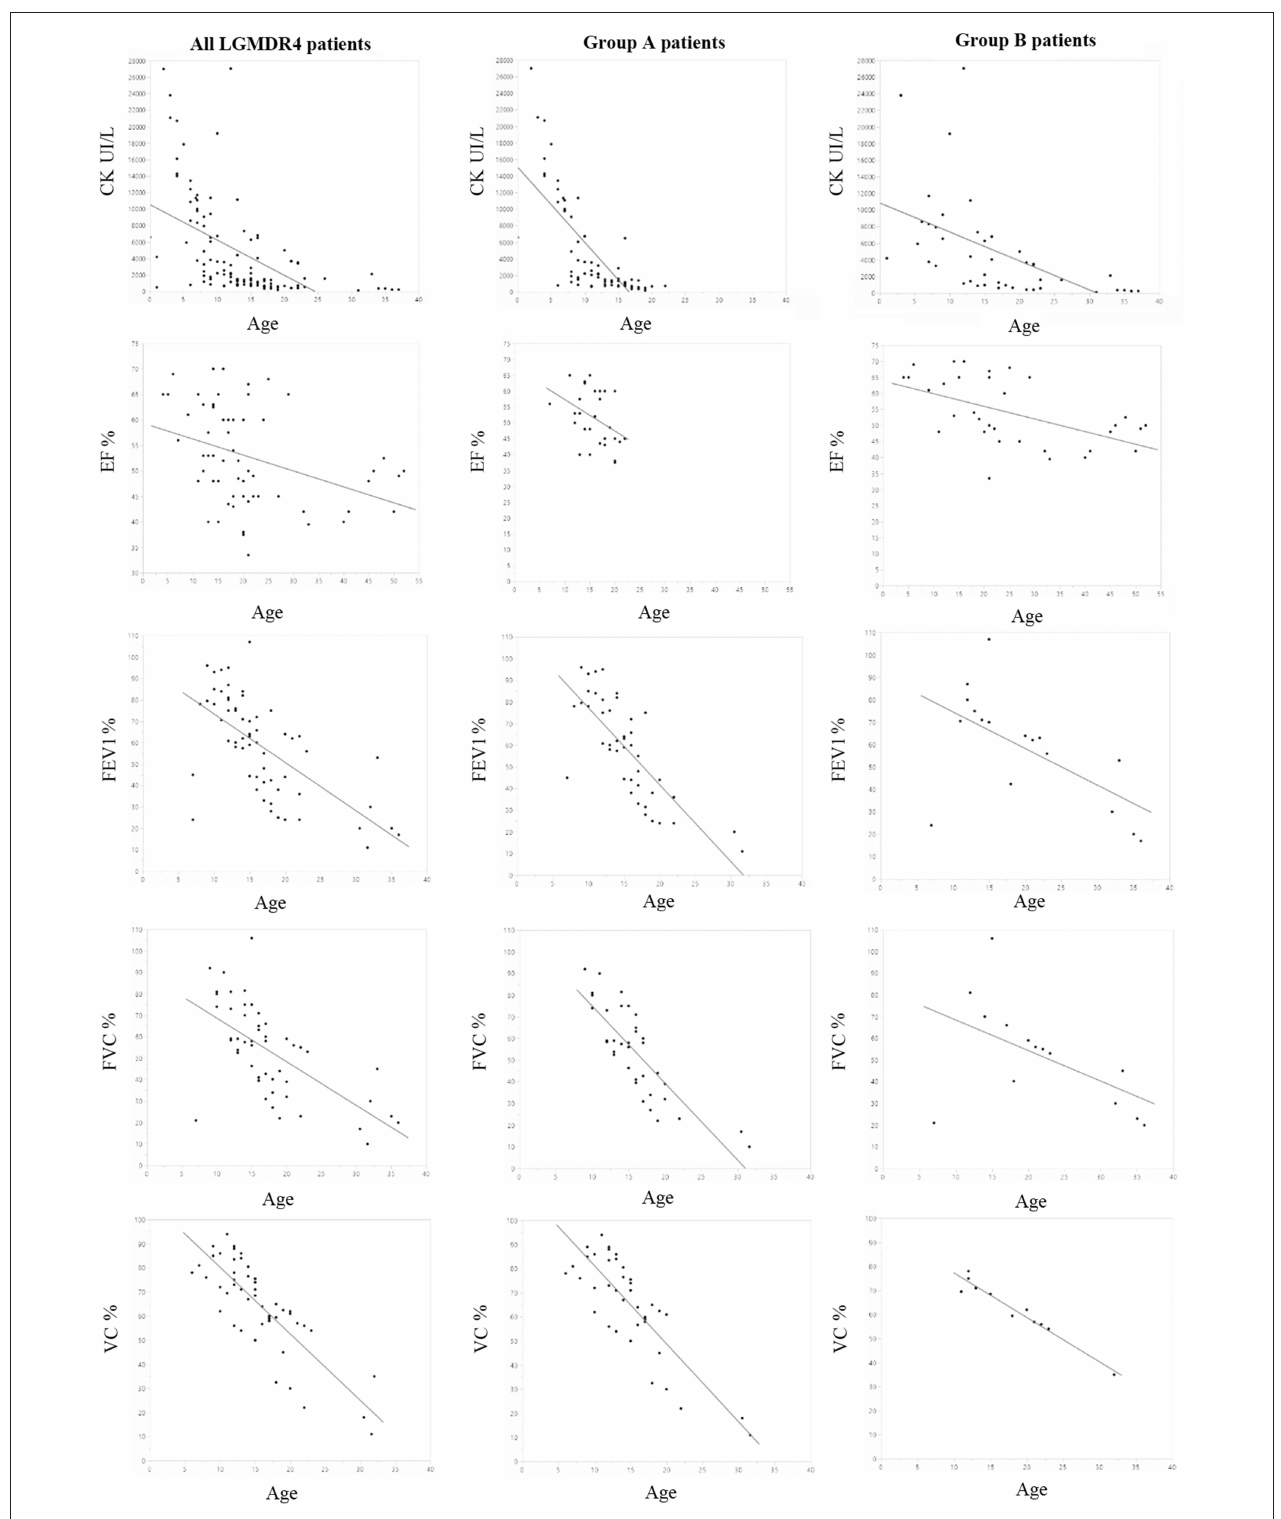
FIGURE 1 | All graphics were created using JMP by SAS. First line: evolution of CPK in all patients and in groups A and B over the years: on the Y axis, CPK values expressed in UI/L; on the X axis, age expressed in years ( p -value 8.3e-10 total patients, p = 2E-13 group A and p = 2.80E-04 group B). Second line: evolution of EF in all patients and in groups A and B over the years: on the Y axis, EF values expressed as percentage; on the X axis, age expressed in years ( p -value 0.0023 total